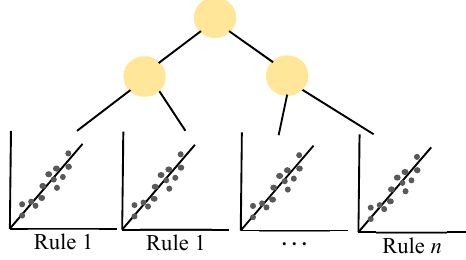
Figure A6. The introduction to Boosted Regression Tree.